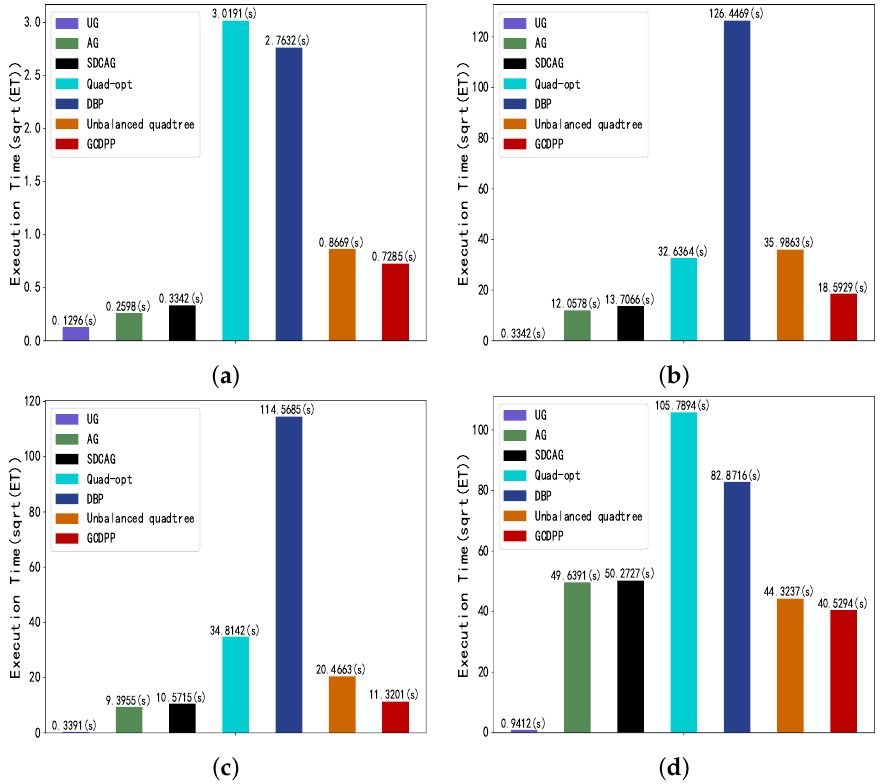
Figure 15. Comparison of operating efficiency of various algorithms under different datasets. ( a ) Stor- age dataset, (cid:101) = 1; ( b ) Landmark dataset, (cid:101) = 1; ( c ) Checkin dataset, (cid:101) = 1; ( d ) Yellow_trip dataset, (cid:101) =